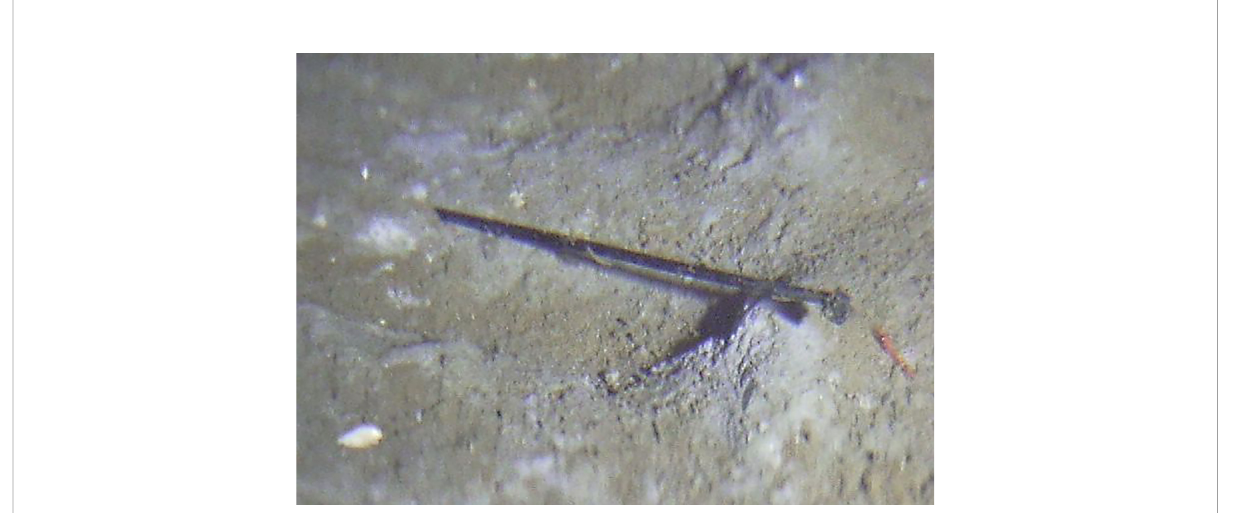
FIGURE 11 Zip tie on the seabed, as an example of marine litter encountered by the crawler during different missions (image taken on September 27